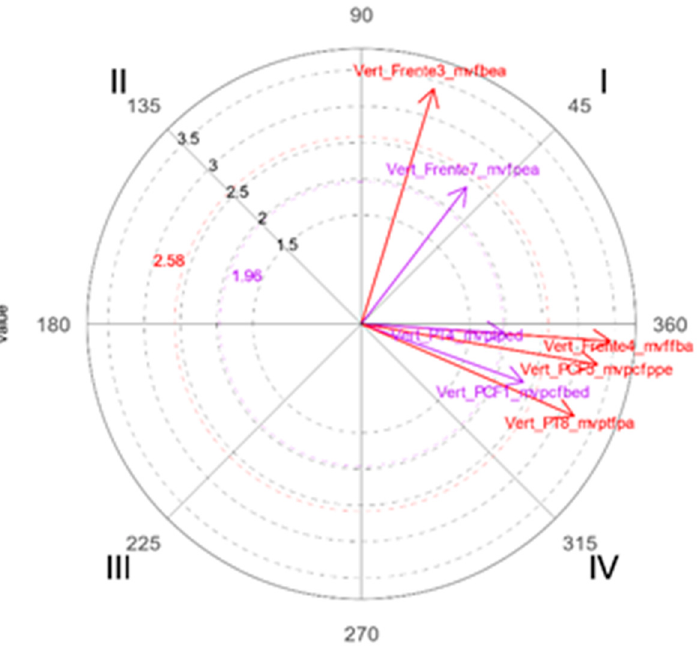
Figure 4. Polar coordinate map of the rabbit character with the highest number of significant vectors in the representation of the movement macrocategory in the drawings at 8 years of age. Table 2. Most significant vectors of the macrocategories in each age for the two characters according to the quadrant.